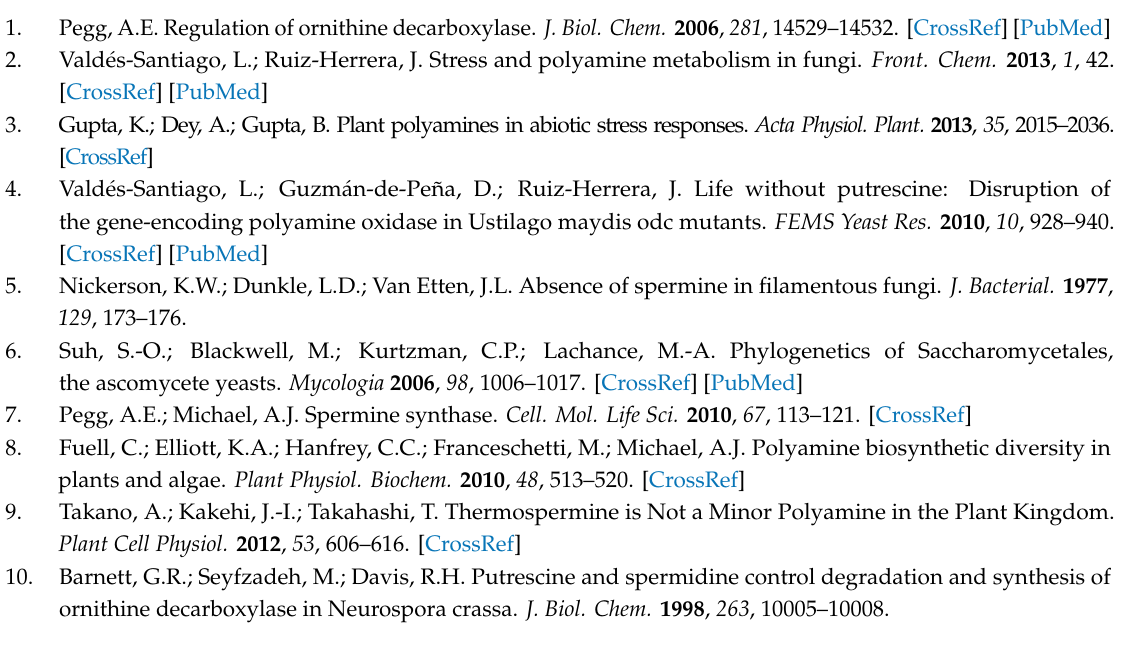
Supplementary Materials: The following are available online, Table S1: Potentiality of recovered fungal